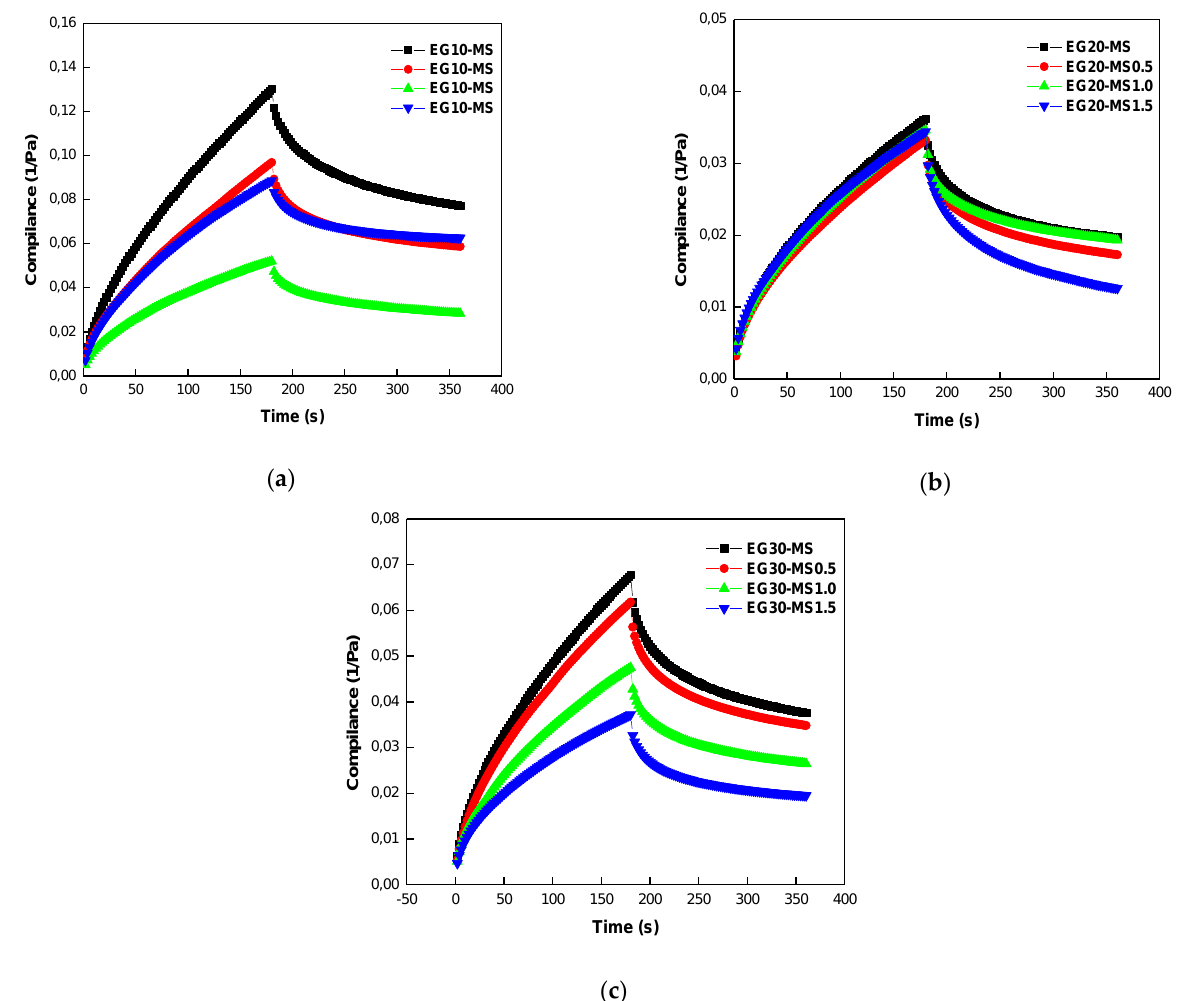
Figure 5. Creep and recovery curves of carboxymethyl cellulose/mango-starch emulsion gels with 1% w/w of mango peel extracts at ( a ) 10%, ( b ) 20% and ( c ) 30% of canola oil.